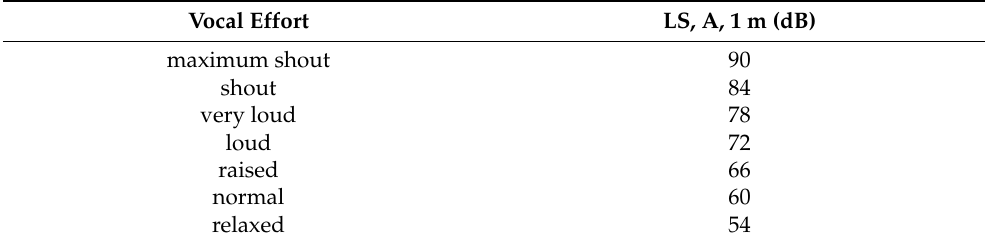
Table 7. Vocal level according vocalization effort of a regular male. Vocal